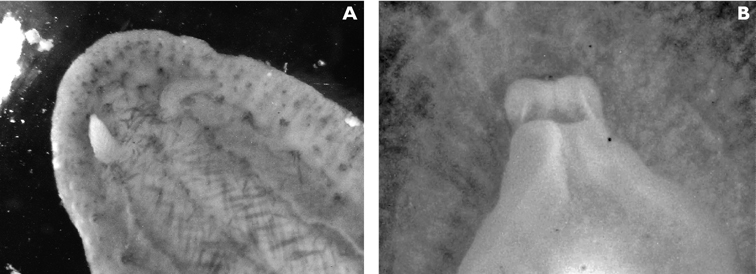
Phyllidiopsis xishaensis
A dorsal view of anterior end of 15 mm specimen B ventral view of propodium of 21 mm specimen.